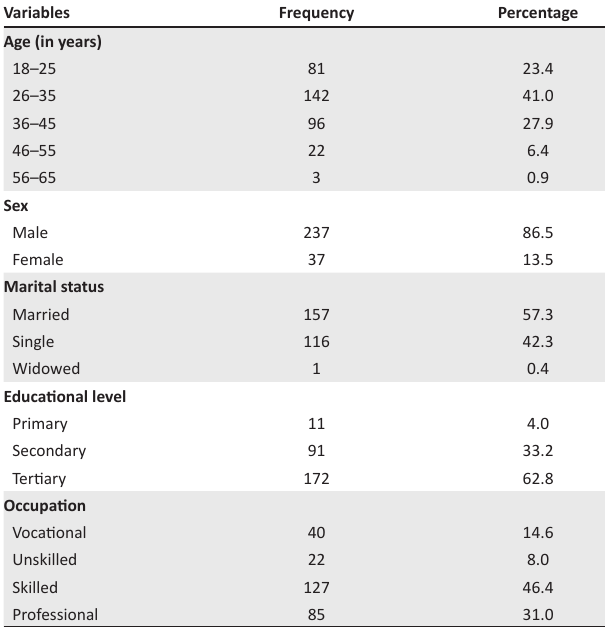
TABLE 1: Demographic characteristics of 274 blood donors in Ibadan, Nigeria, between April 2019 and May 2019. Variables